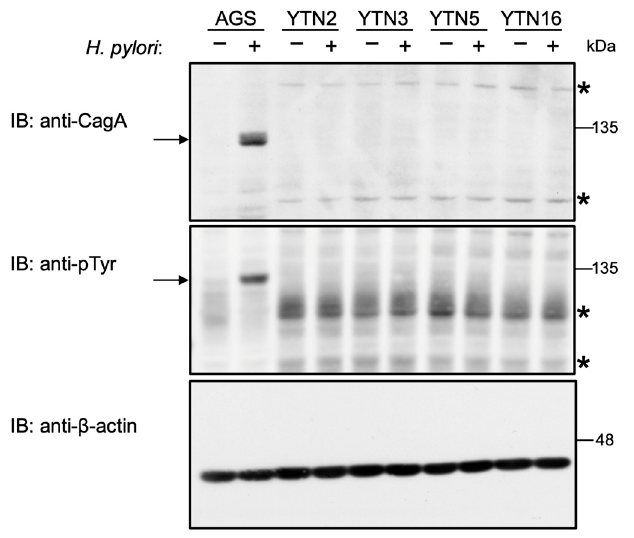
Figure 2. Infection with cagA -positive H. pylori is not able to deliver CagA into mouse gastric epithelial cells. Mouse gastric epithelial cells (YTN2, YTN3, YTN5, and YTN16) and AGS human gastric epithelial cells were infected with H. pylori NCTC11637 strain for 7 h at a MOI of 100. The cells were harvested and analyzed for CagA and tyrosine phosphorylation (pTyr) of CagA proteins. CagA is detectable at 135 kDa as indicated by the arrow in the anti-CagA and anti-pTyr immunoblot. Asterisks (*) denote the non-specific band observed for cell lysates of mouse origins. Representative image of two independent experiments. Experiments were carried out in biological duplicates ( n = 2) and the representative images are